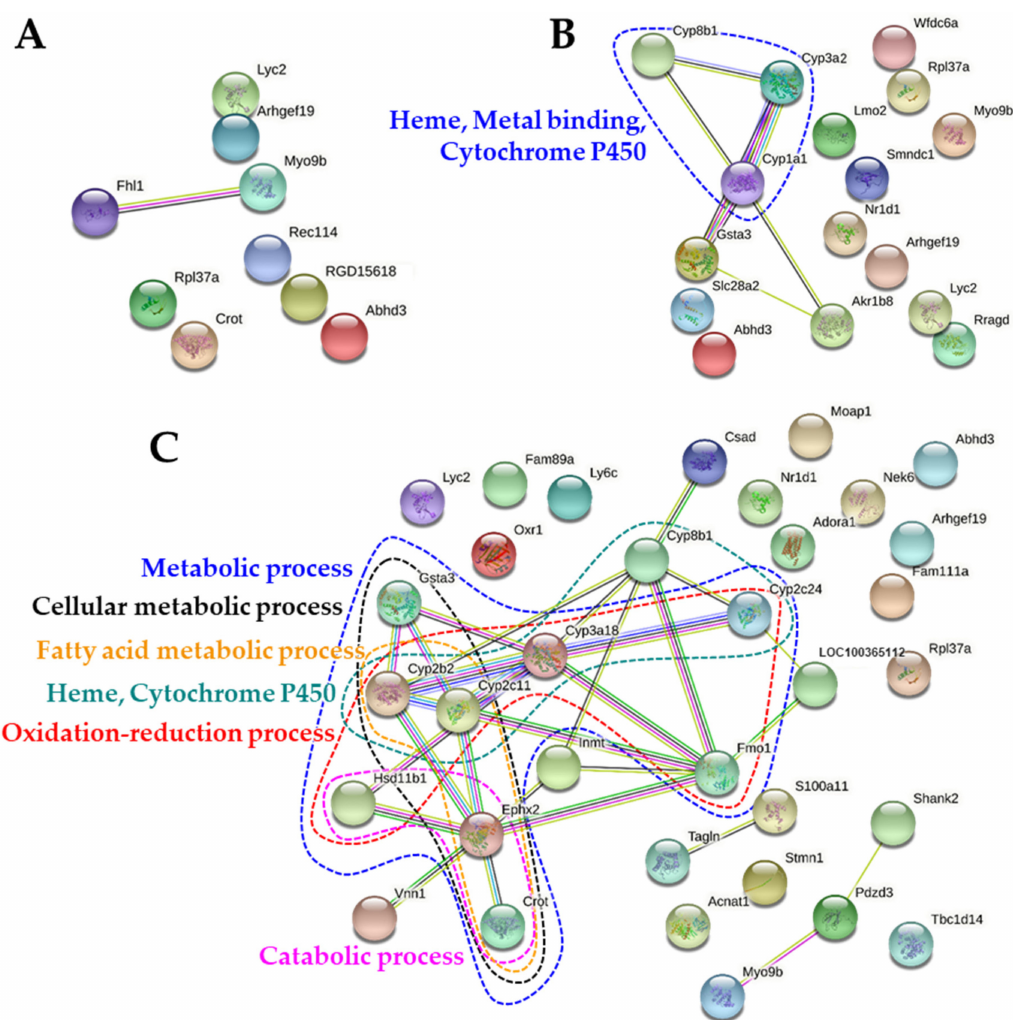
Figure 7. Protein-protein interaction (PPI) networks of up-regulated differentially expressed genes (DEGs) in the rat livers after 14-day repeated oral administration of ( A ) B-ZnO, ( B ) N-ZnO or ( C ) Zn